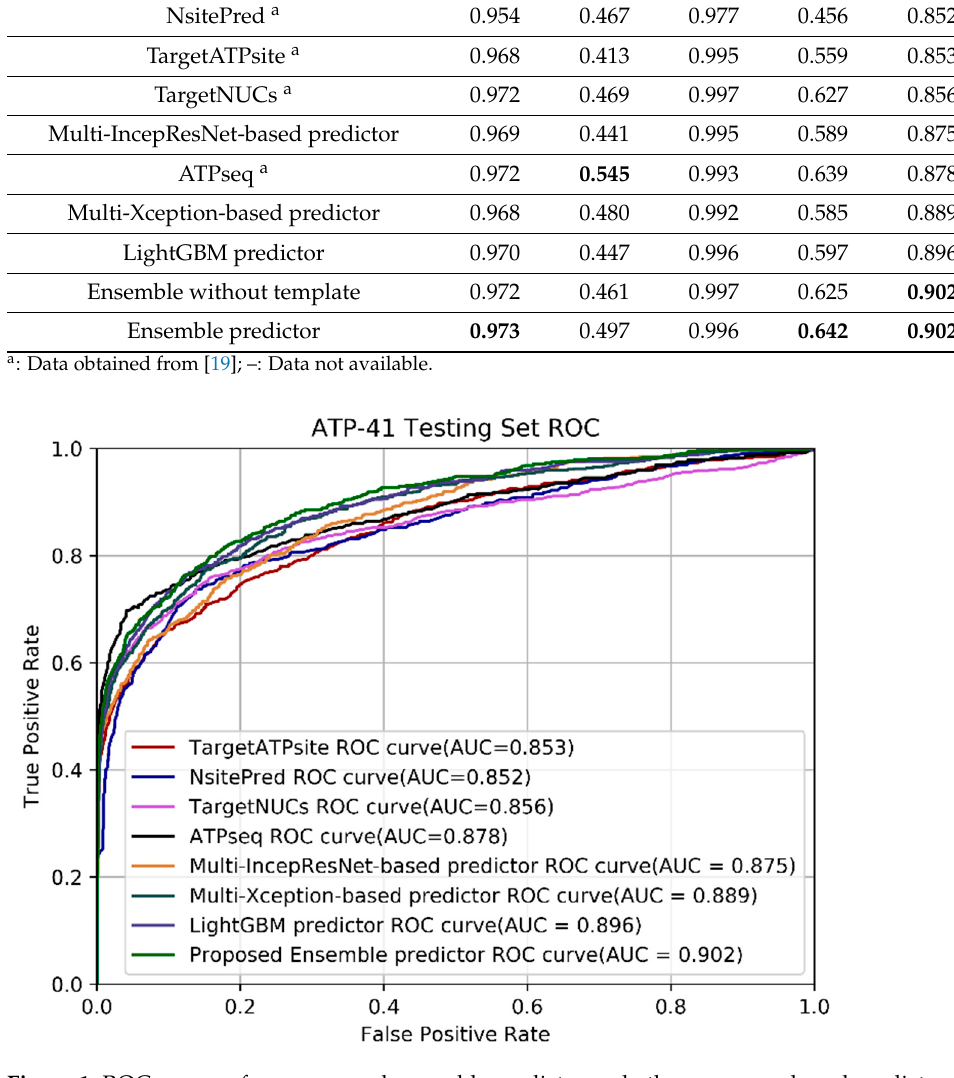
Figure 1. ROC curves of our proposed ensemble predictor and other sequence-based predictors on the ATP-41 testing set.